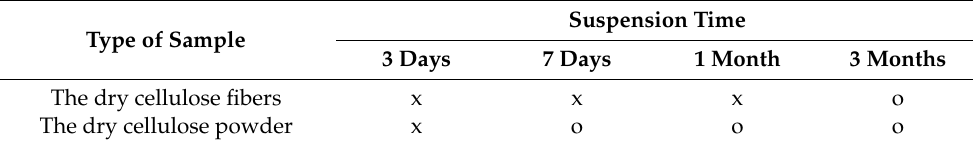
Table 2. Comparison of suspension quality.